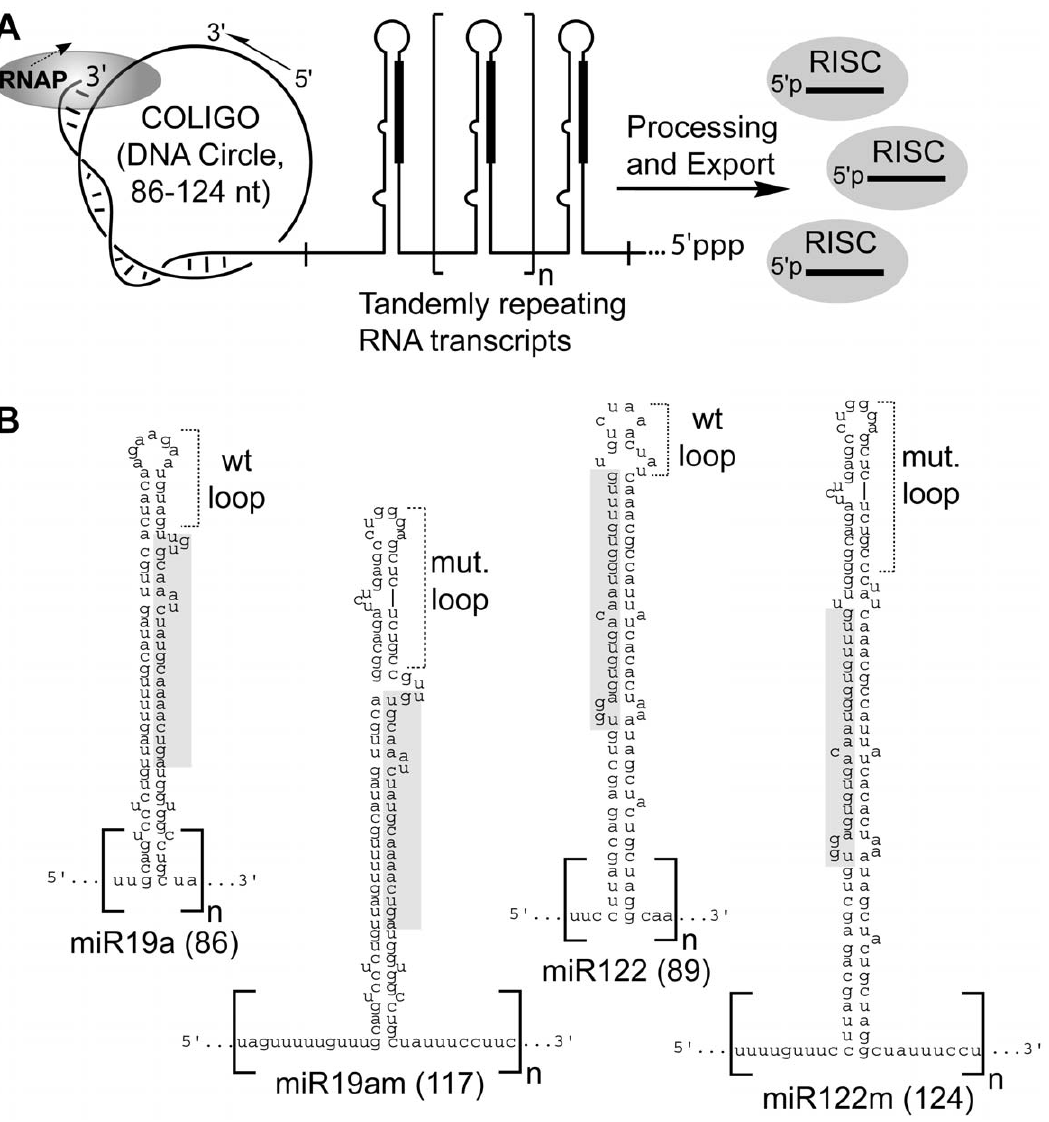
Figure 1. Rolling Circle Transcription (RCT) approach to expressing miRNA, siRNA and other small RNA. A . Circular oligodeoxynucleotides (COLIGOs) are made to encode minimal pri-miRNAs. RCT would produce tandemly arrayed primary miRNA stem-loops resembling naturally occurring miRNA clusters to promote entry into the endogenous miRNA maturation pathway, and Argonaute effector complexes (RISC) programming. B . RNA transcript sequences and the predicted secondary structures of the four COLIGOs used in this study. Mature miRNA are shaded, number in parentheses refers to number of nucleotides in COLIGO and its monomeric transcript, which is shown arbitrarily beginning outside of the